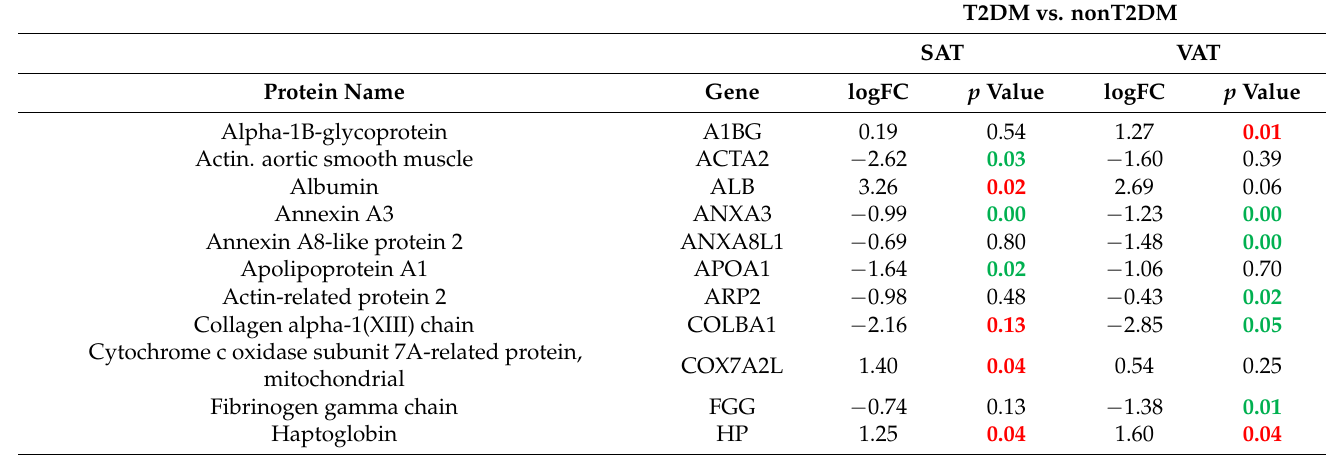
Table 5. Significance of changes in differential protein expression in T2DM versus non-T2DM individuals in VAT and SAT